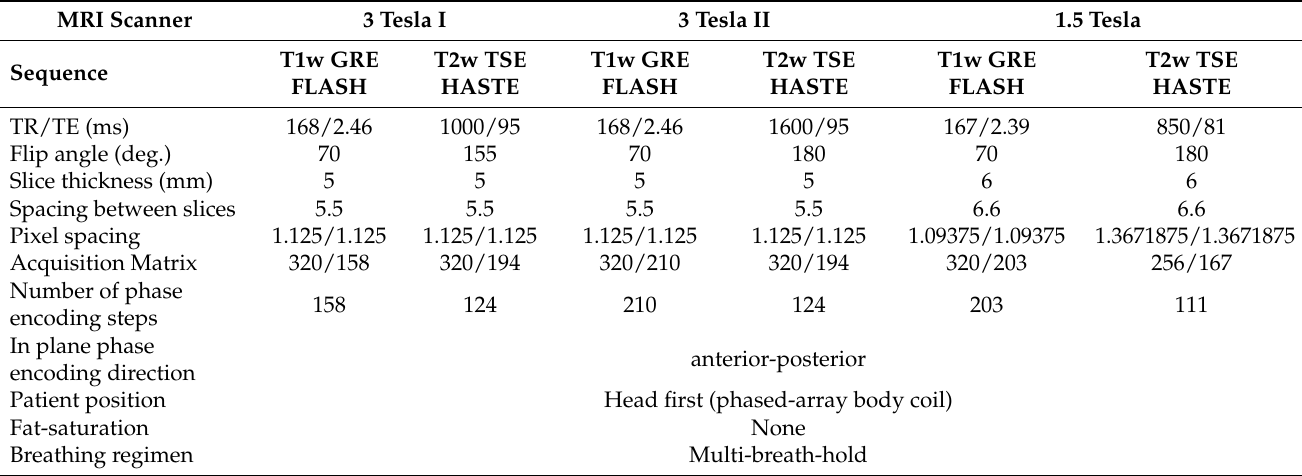
Table 2. Details of the MRI scanning